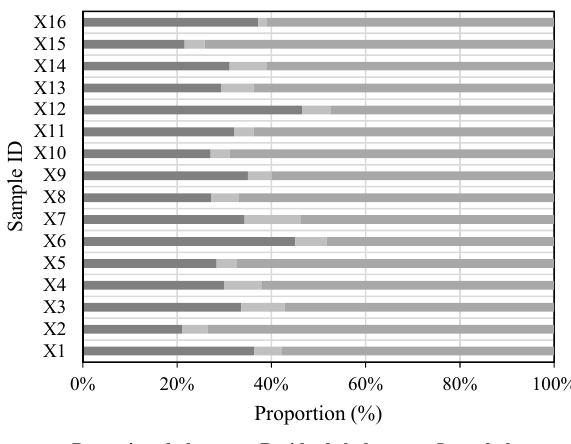
Figure 10. The proportion of degassing shale gas content, residual shale gas content and lost shale gas content.